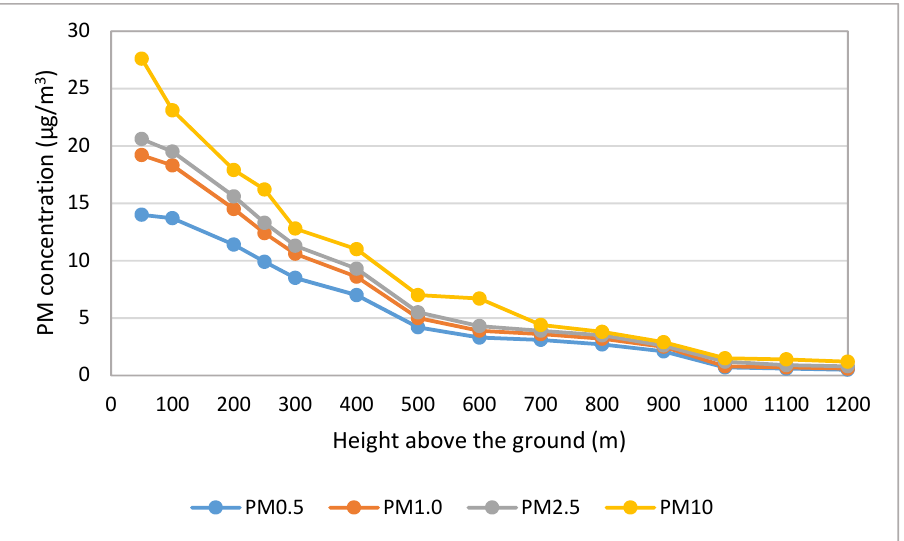
Figure 8. Summary of concentrations of dust fractions as a function of height above ground level (data from measurement apparatus installed on the balloon basket).